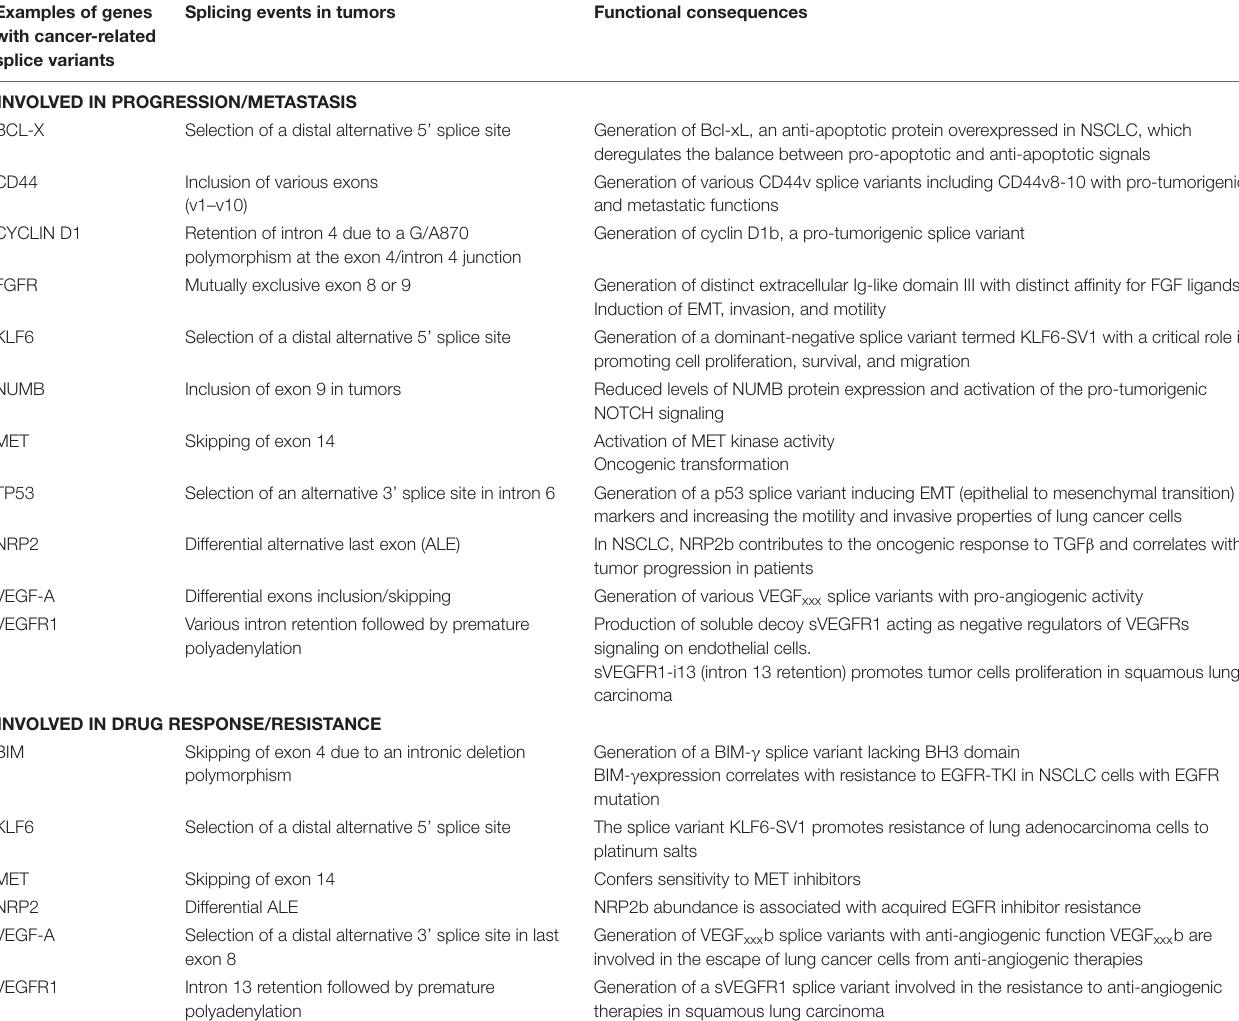
TABLE 1 | Examples of genes with splice variants associated with lung cancer progression and/or response to therapies. Examples of genes with